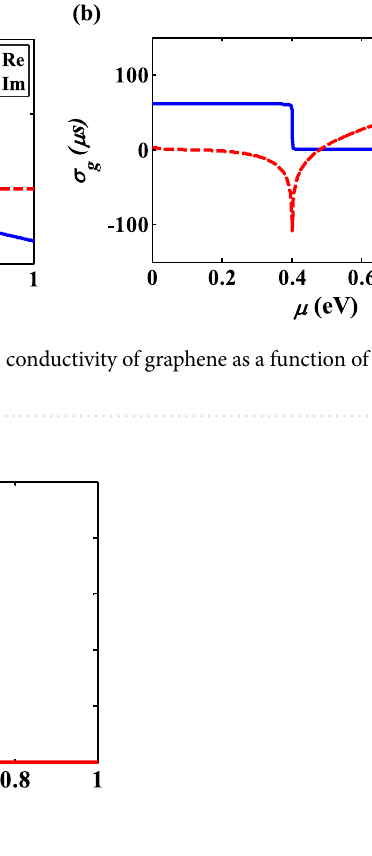
Figure 8. The ratio of Im (cid:31) ε g (cid:30) and (cid:31)